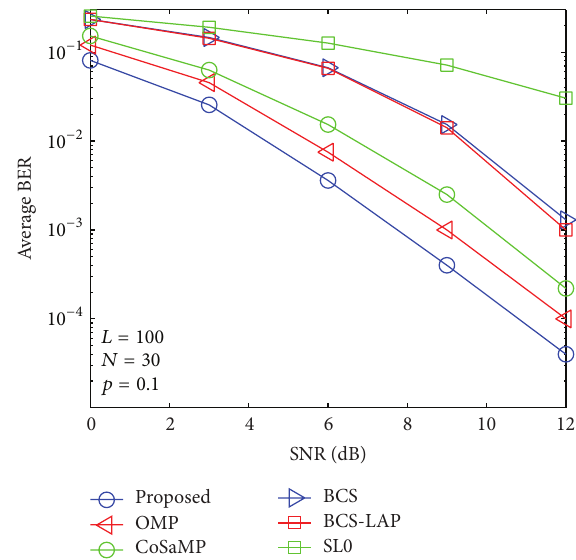
Figure 8: Average MSE performance versus SNR when 𝑝 1 = 0.2 and 𝑁 = 40 .